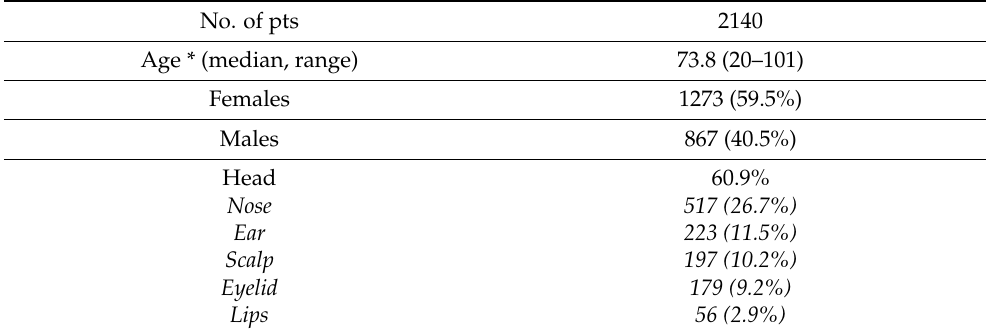
Table 1. Clinical and pathological characteristics of patients affected by